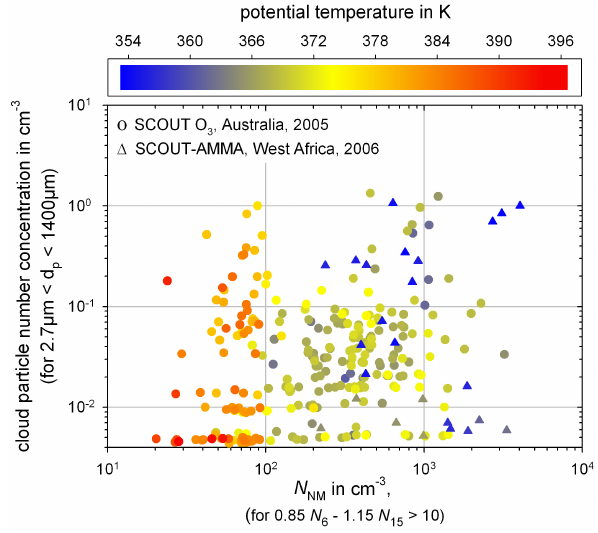
Fig. 12. NPF events observed during the SCOUT-O 3 and the SCOUT-AMMA missions (Australia 2005 and West Africa 2006, respectively) when simultaneously cloud elements were detected. NPF can be observed only if cloud particle num- ber concentrations (from FSSP-100 and CIP measurements with 2.7µm <d p < 1.4mm) remain below 2 particles per cm 3